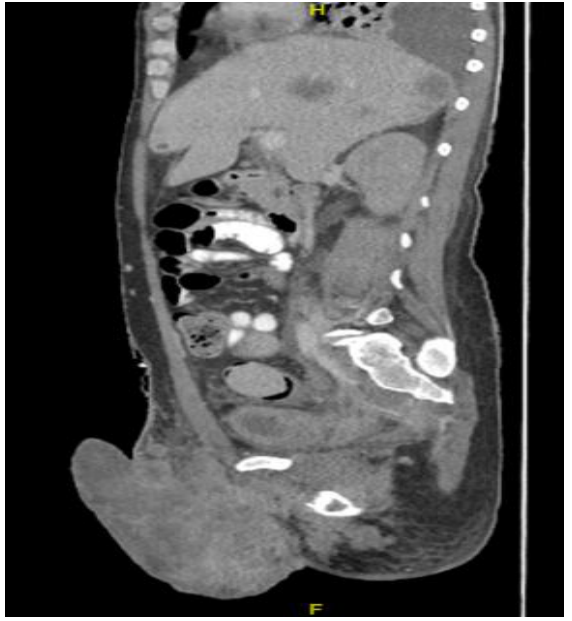
Figure 8. CT in the sagittal view, abdominal window, showing scrotal mass extending to erect penis.